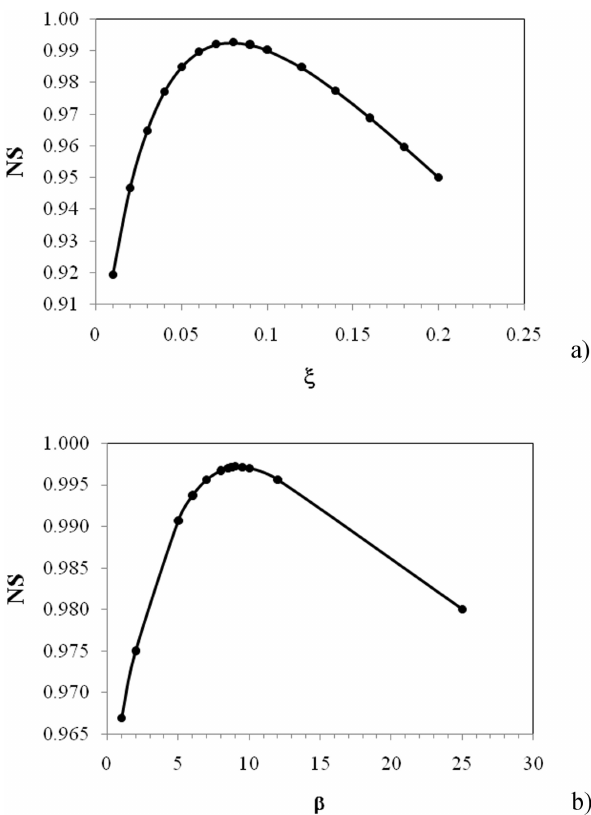
Figure 2. NS versus ξ and β curves, respectively, for INCM (a) and LHRM (b) methods.